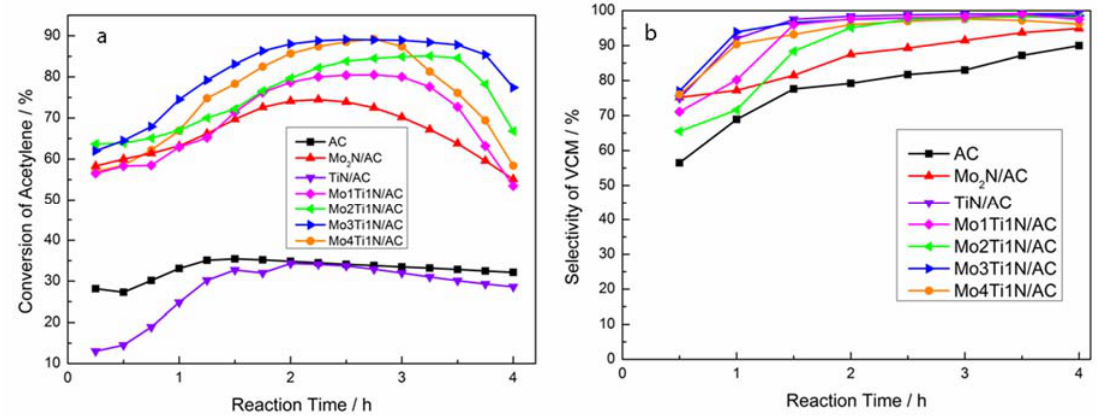
Figure 3. The ( a ) acetylene conversion and ( b ) VCM selectivity over catalysts of AC,